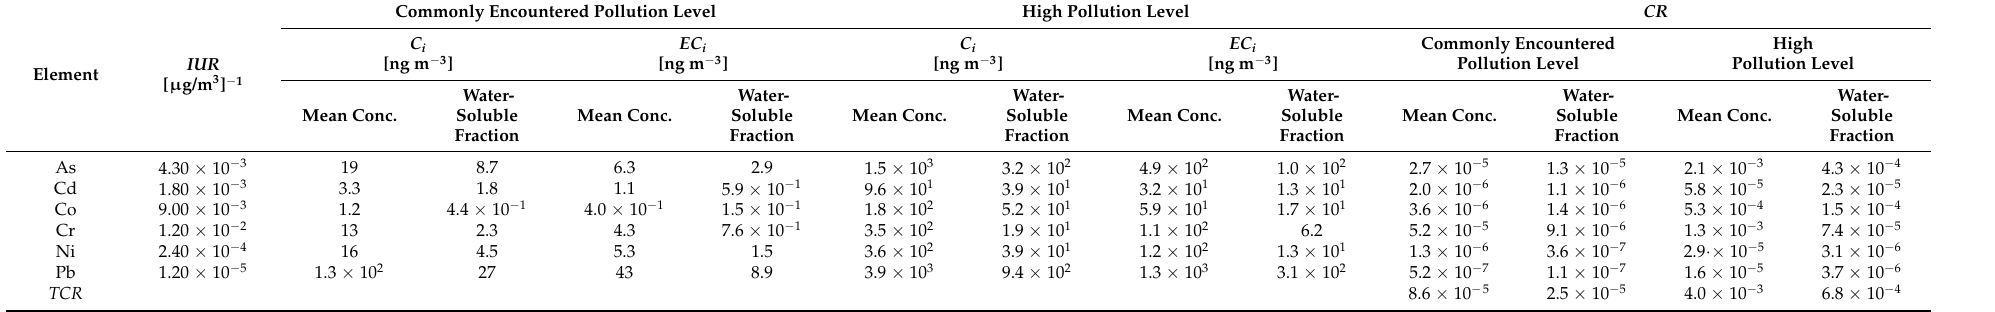
Table 9. Non-carcinogenic risk from metallic and metalloid elements via inhalation exposure to airborne particles. Commonly Encountered Pollution Level High Pollution Level HQ Water- Mean Conc. Soluble Fraction